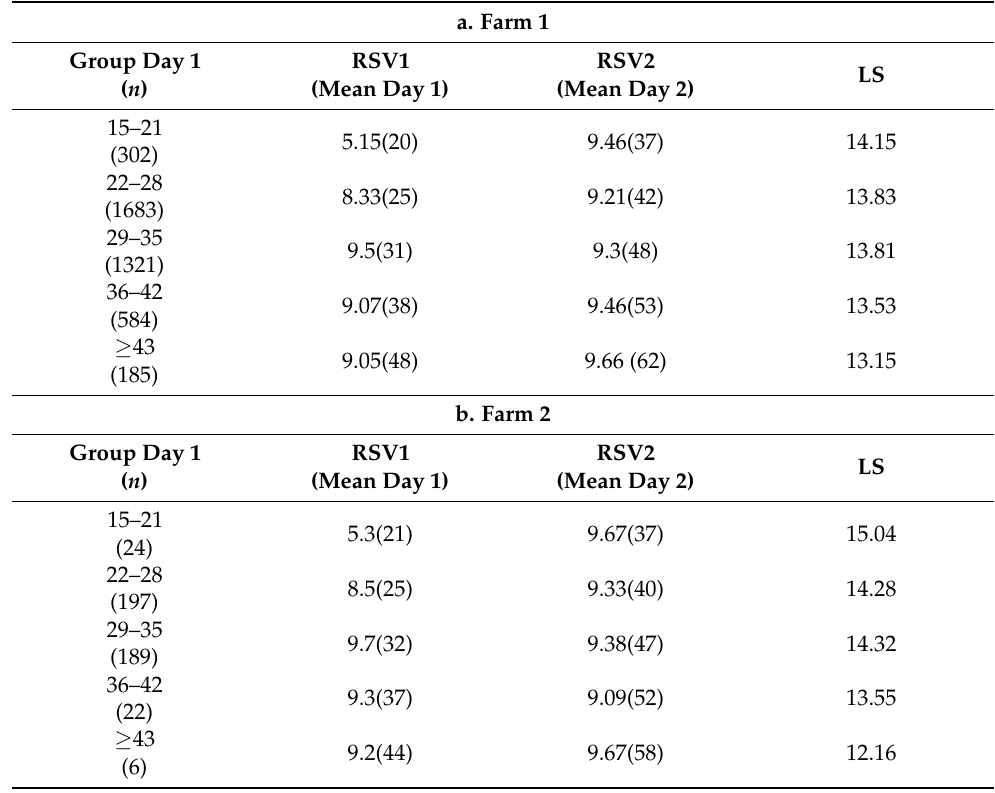
Table 2. Mean RSV values with days of the scan and litter size (LS) of the sows, grouped in weekly intervals of Day 1. a. Farm 1 (overall), b. Farm